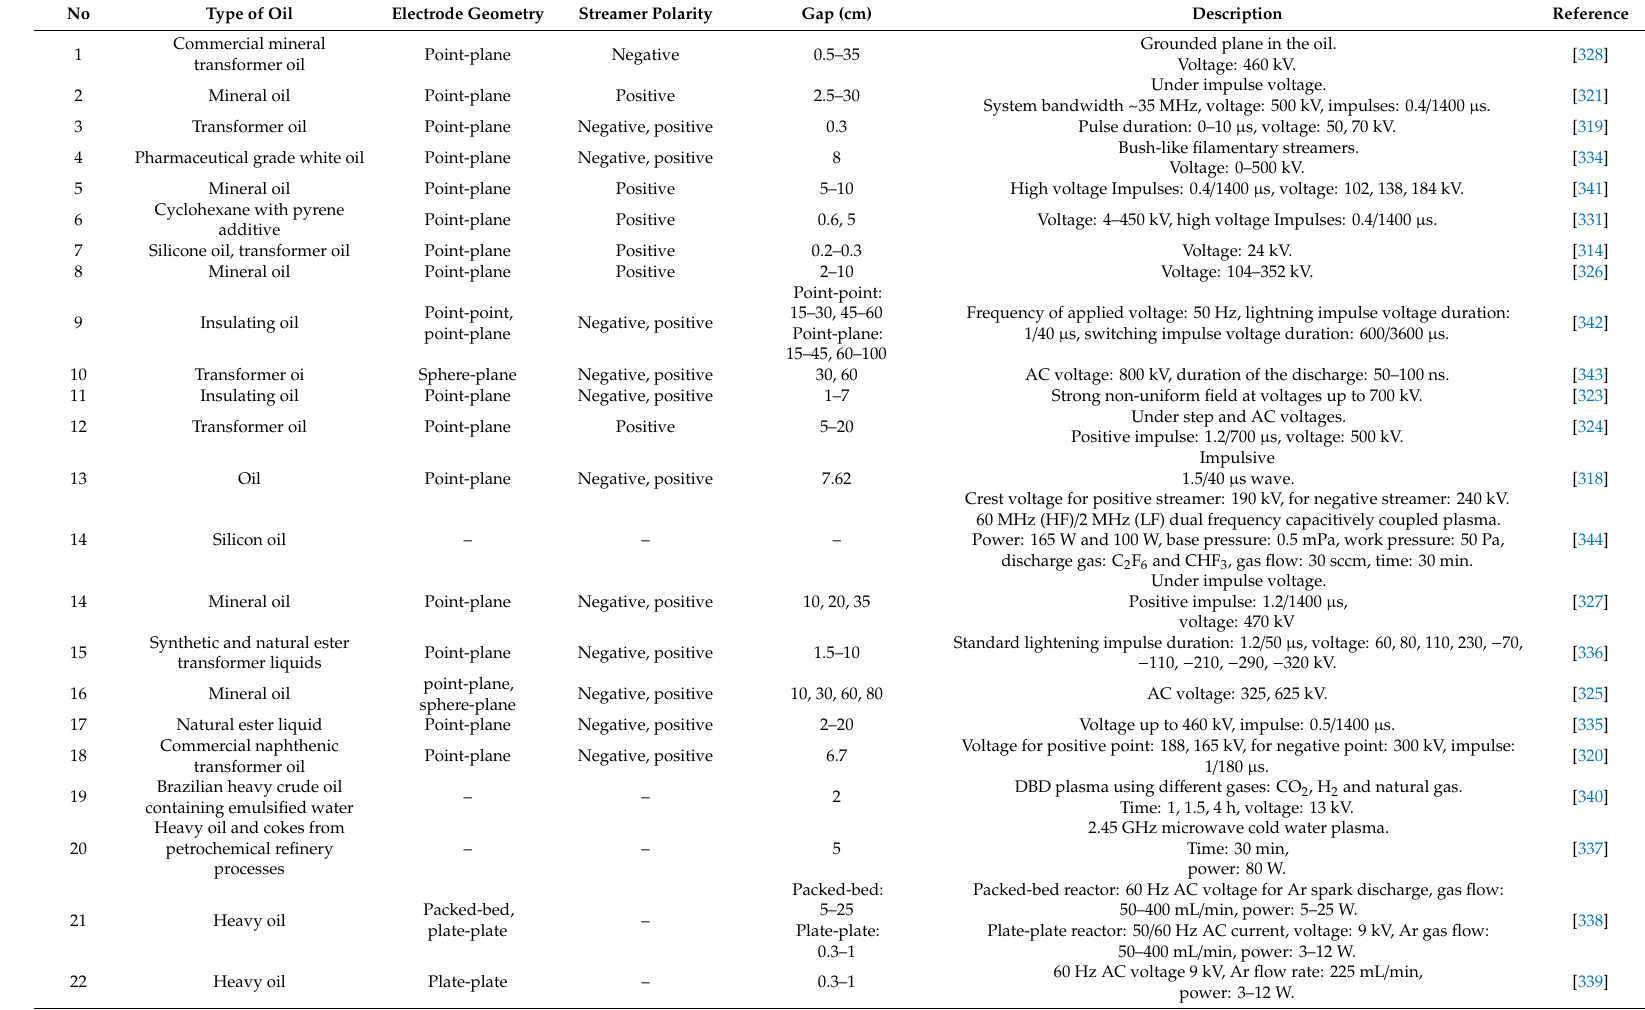
Table 9. Overview of studies dealing with plasma electrical discharges in dielectric